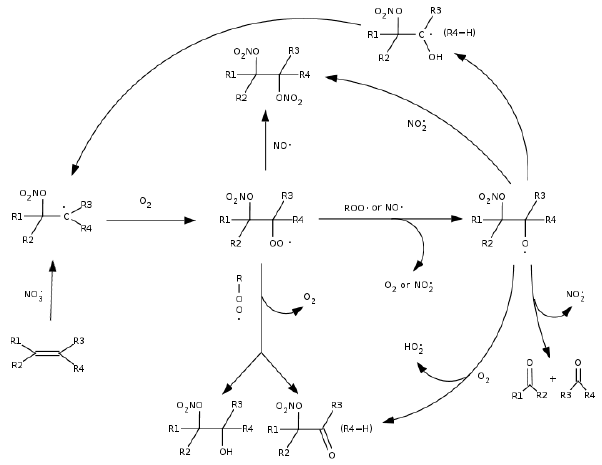
Fig. 2. Mechanism for NO 3 oxidation of an alkene.